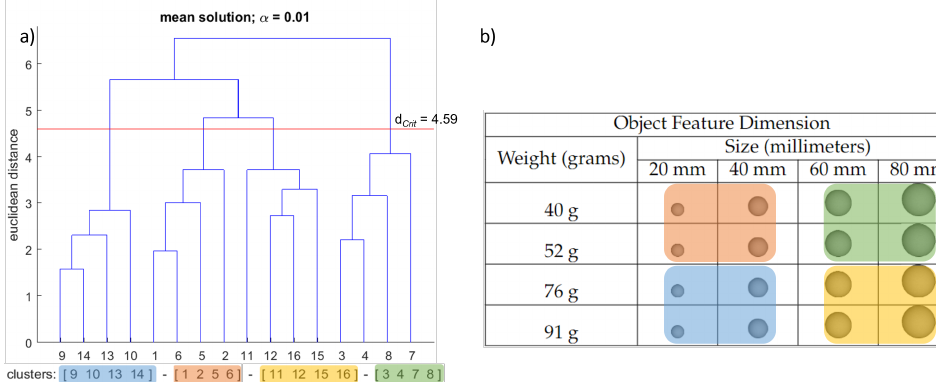
Figure 3. Results averaged among participants for the “lifting” condition. ( a ) Mean dendrogram showing the resulting sensorimotor representation structure. The red horizontal line denotes the Euclidean critical distance. The critical value of the Euclidean distance was 4.59 at a 1% level of signif- icance (i.e., d Crit = 4.59, α = 0.01). Clusters that occur beneath the horizontal red line are statistically significant. ( b ) Spheres used in the experiment with their corresponding feature dimension levels. ( a , b ) Each color represents a significant cluster and its corresponding subset of